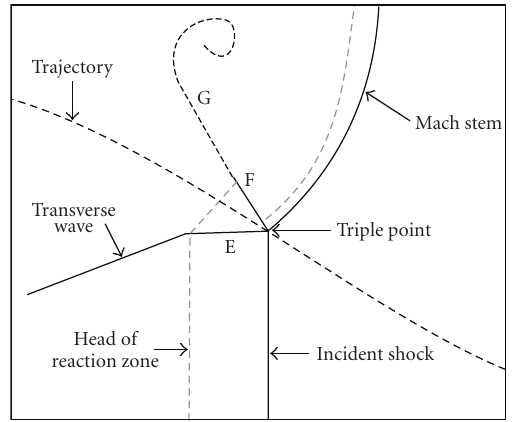
Figure 3: Enlargement of the Mach reflection pattern around a periodical triple point configuration. E: reflected shock, F: slip line, G: di ff usive extension of slip line with flow